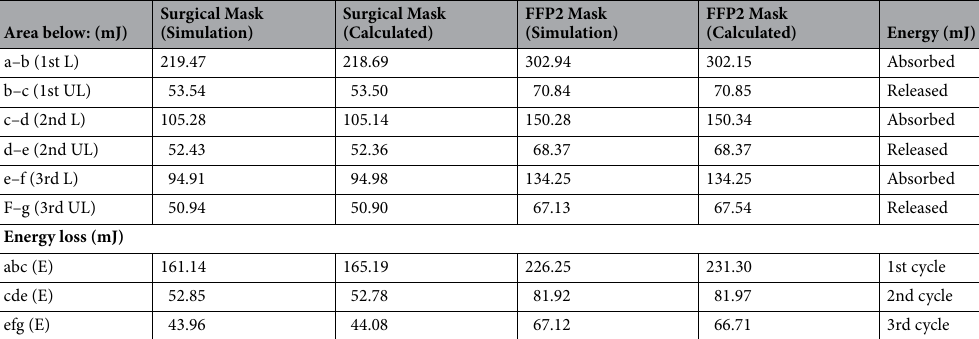
Table 1. Enclosed areas under the loading and unloading curves for the surgical and FFP2 face masks. The energy loss has been calculated and simulated for each hysteresis loop for both masks. L loading; UL unloading; E enclosed